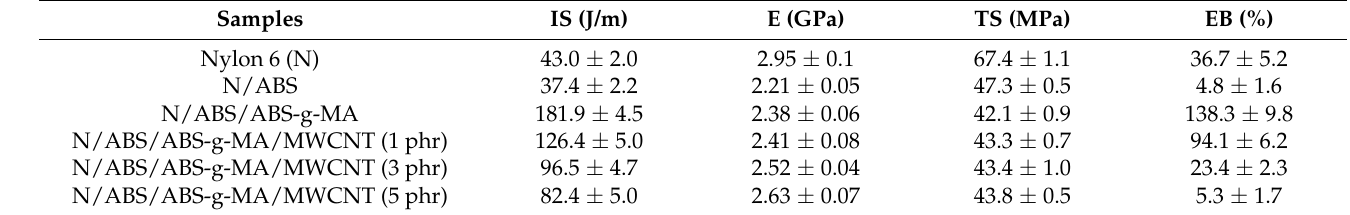
Figure 10. Mechanical properties of Nylon 6, blends, and nanocomposites: ( a ) impact strength vs. elongation at break; ( b ) elastic modulus vs. tensile strength. N = Nylon 6. Table 1. Mechanical properties of Nylon 6, blends, and nanocomposites. IS = impact strength; E = elastic modulus; TS = Tensile strength at yielding; EB = elongation at break; N = Nylon